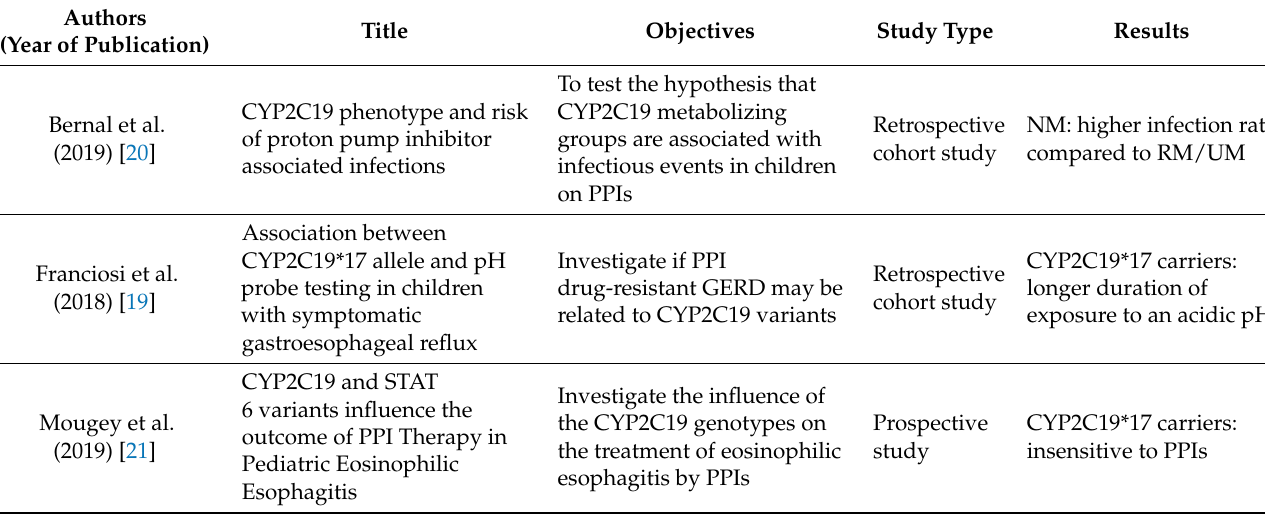
Table 3. Summary of studies on the influence of CYP2C19 genotype on